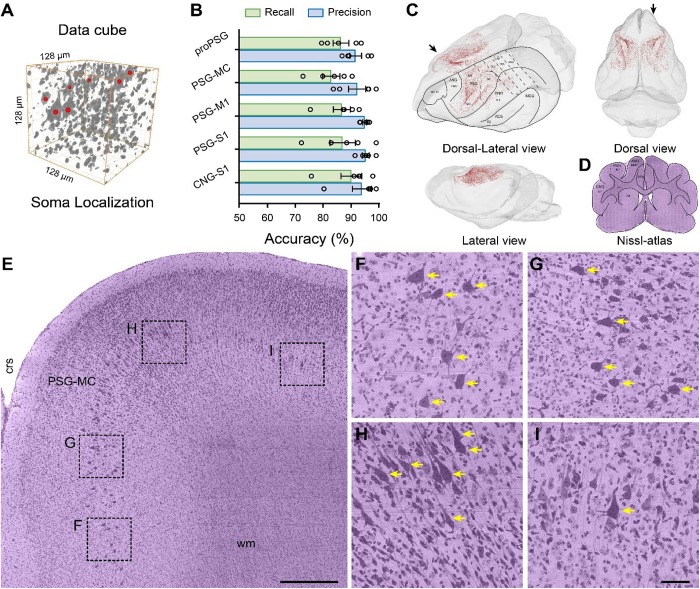
Brain-wide distribution of giant PyNs in whole ferret brains. (A) The location of giant PyNs within the 3D data cube was determined using the NeuroGPS algorithm; red dots indicate the center of somata of giant PyNs in the 128 μm × 128 μm × 128 μm 3D data cube. (B) Accuracy of automatic localization of giant PyNs (n = 5 data blocks [512 μm × 512 μm × 512 μm] per brain region). Green and blue columns represent the recall and precision values, respectively. (C) 3D visualization of brain-wide distribution of giant PyNs in various side views. Red dots indicate the center of somata of giant PyNs. Delineations of main cortical areas of ferret brain were plotted taking ferret brain atlas (Radtke-Schuller, 2018) and Nissl-cytoarchitectures as reference. (D) Delineations of brain areas of ferret brain in representative coronal plane, and the black arrow in (C) (dorsal-lateral view) shows the orientation of the coronal plane. (E) 2D view of giant PyNs distributed in the ferret motor cortex of the PSG (sagittal plane). The black arrow in (C) (dorsal view) shows the orientation of the sagittal plane. Scale bar, 400 μm. (F–I) High magnification views of giant PyN distribution, as shown in (D). Yellow arrows indicate representative giant PyNs. Scale bar, 50 μm. AEG, anterior ectosylvian gyrus; ASG, anterior sigmoid gyrus; Cd, caudate nucleus; CGa, cingulate cortex, anterior part; CNG, coronal gyrus; crs, cruciate sulcus; cw, cerebral white matter; dPFC, dorsal prefrontal cortex; LG, lateral gyrus; M1, primary motor cortex; MC, motor cortex; MEG, medial ectosylvian gyrus; PMC, premotor cortex; PPc, posterior parietal cortex, caudal part; PPr, posterior parietal cortex, rostral part; PSG, posterior sigmoid gyrus; S1-3, primary/secondary/tertiary somatosensory cortex; wm, white matter.